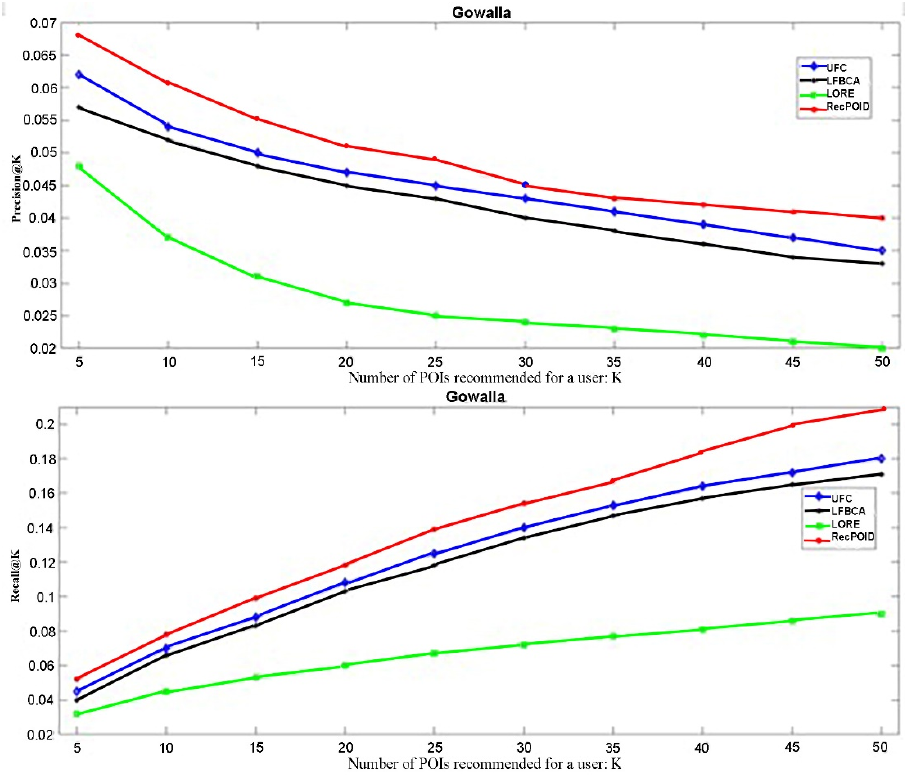
Figure 6. Comparison between RecPOID and the other three methods.